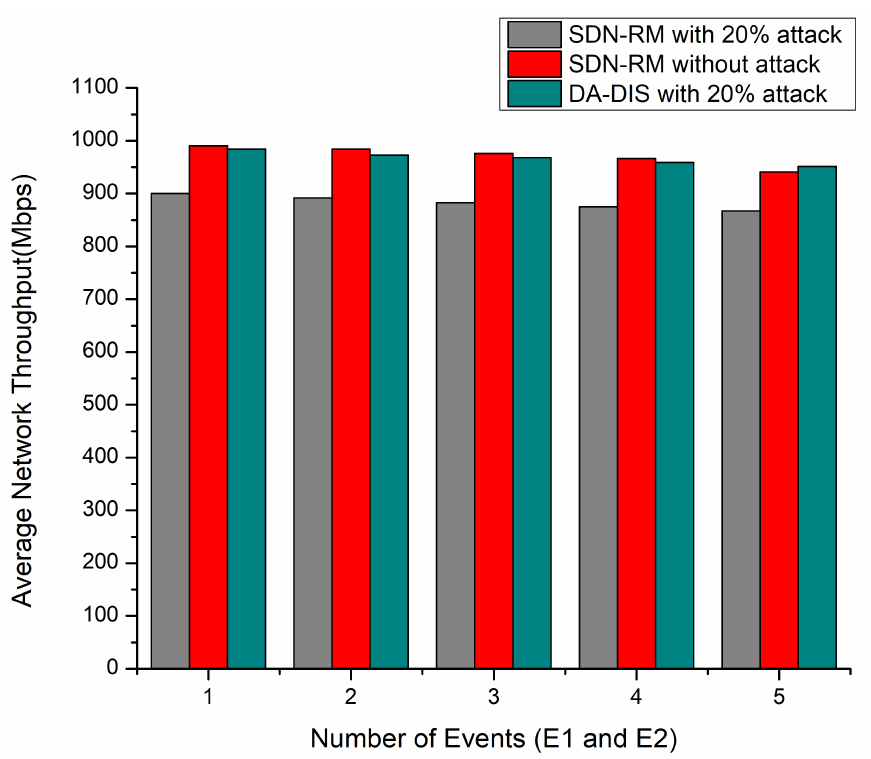
Figure 6. Throughput considering a different number of events (E1 and E2) and 20% malicious